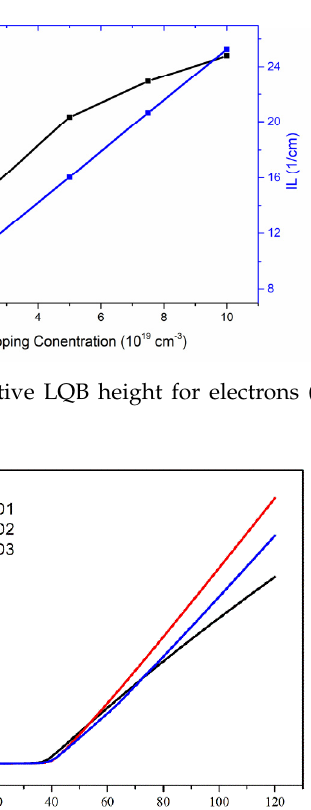
Figure 6. Variation of simulated optical output power and conduction band diagram when different acceptor doping concentration is used for AlGaN layer in CLQB. ( a ) Optical output power at injecting current of 120 mA; ( b ) Conduction band diagram around the MQW region at injecting current of 120 mA. The dashed line represents the electron Fermi level. The doping concentration of p-AlGaN layer in 4 samples is 1.0 (black), 2.5 (red), 5.0 (green), 7.5 (violet) and 10.0 (cyan) ×10 19 cm -3 . The energy scale has been vertically shifted to keep the Fermi level consistent, making it easier to tell the difference.